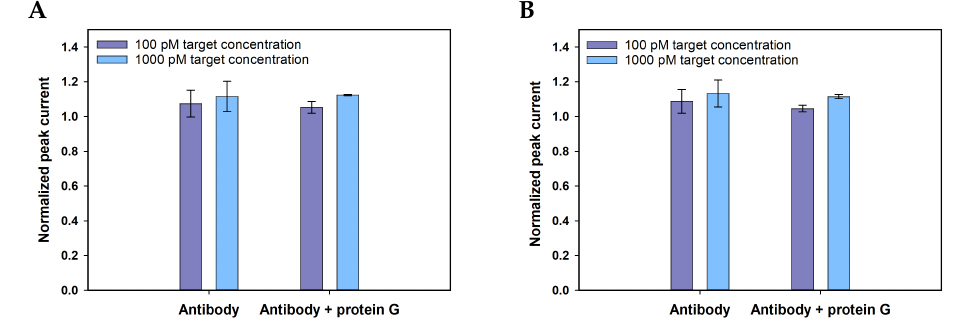
Figure A2. Detection of 100 (purple) and 1000 (blue) pM of the target gene using either the antibody or antibody conjugated to protein G, using both CV ( A ) and DPV ( B )